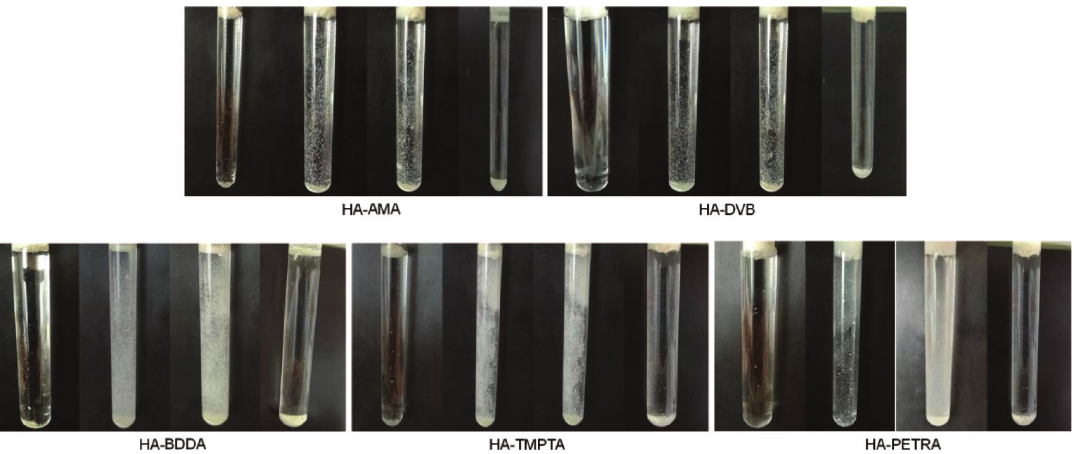
Figure 7: Release effect verification experiment of the temperature controlled release microspheres.